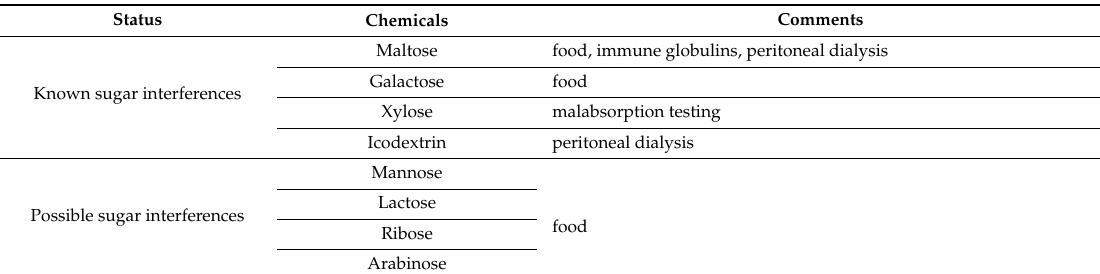
Table 1. Possible interfering electrochemical responses to electrochemical glucose sensors, collected from References [32,49–57].